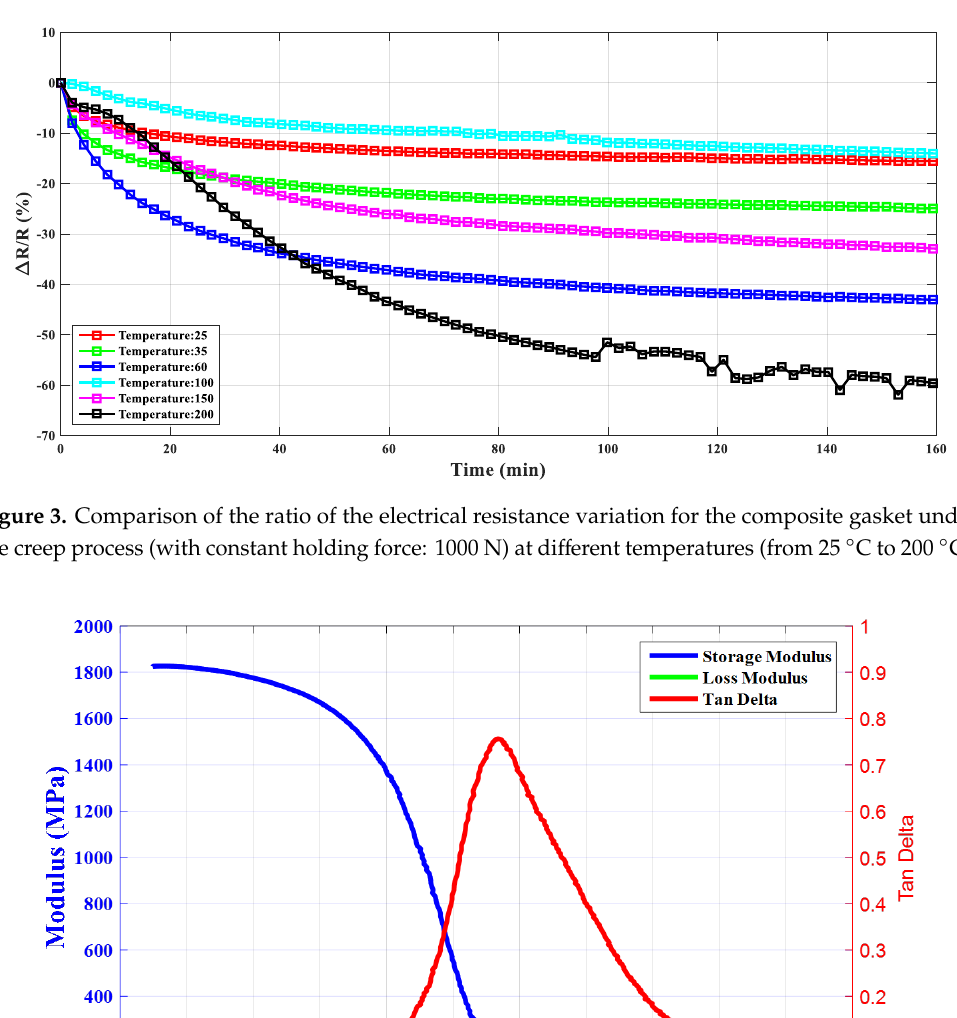
Figure 3. Comparison of the ratio of the electrical resistance variation for the composite gasket under the creep process (with constant holding force: 1000 N) at different temperatures (from 25 °C to 200 °C).